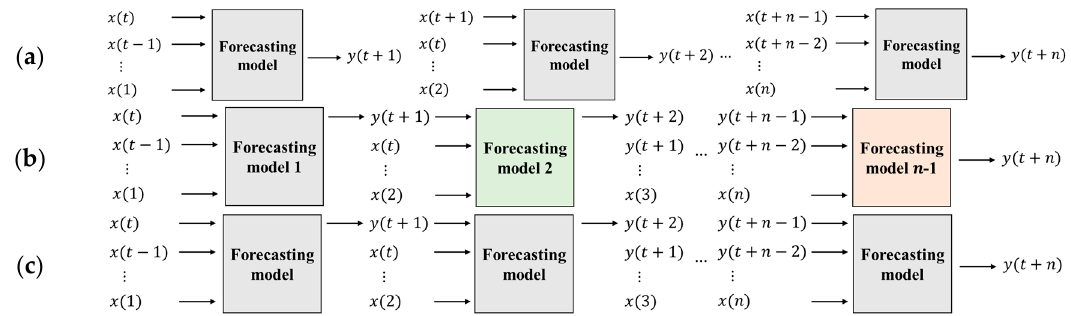
Figure 5. Architectures of forecasting approaches: ( a ) one-step ahead prediction, and ( b ) direct model re-training approach and ( c ) recursive approach for multi-step ahead prediction.